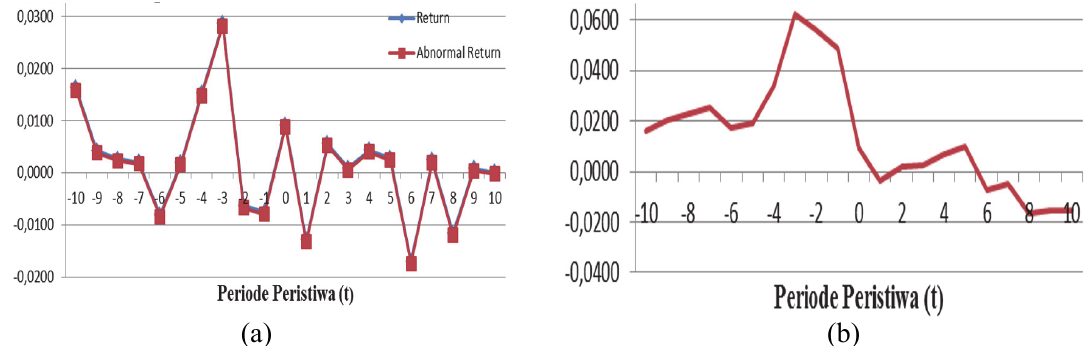
Fig. 3. Movement of (a) Return and Abnormal Return and (b) Cumulative Return on JCI for EPP volume X